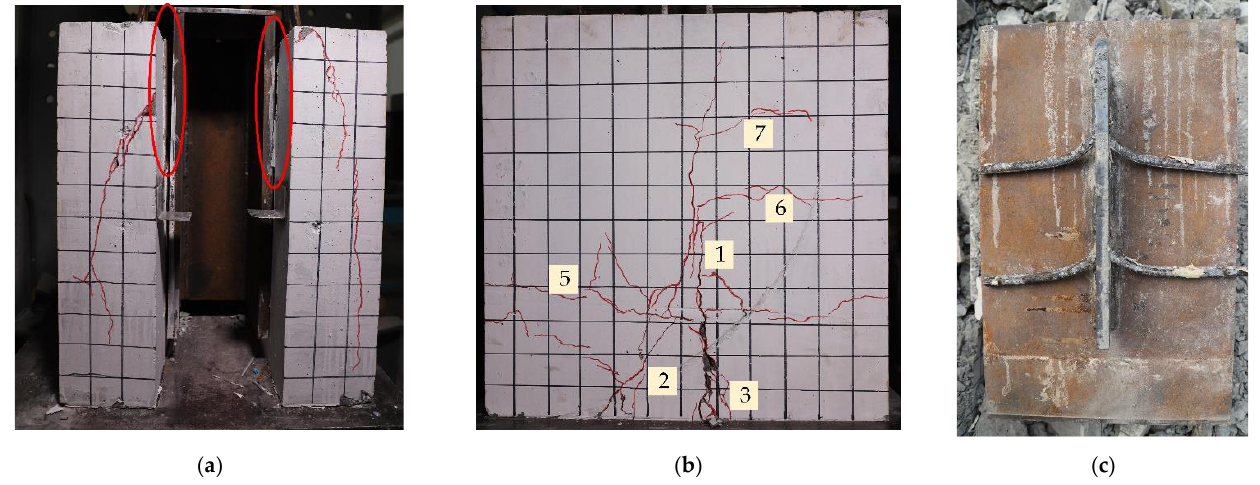
Figure 6. Failure modes of PBL shear connector: ( a ) front of concrete slab; ( b ) side of concrete slab; ( c ) perforated steel plate.